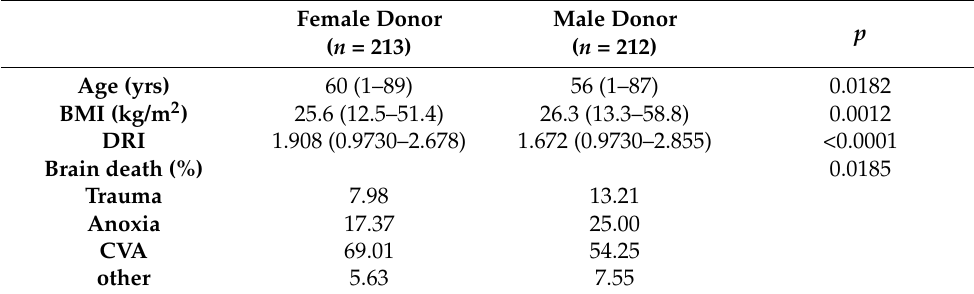
Table 2. Donor characteristics stratified according to donor sex.